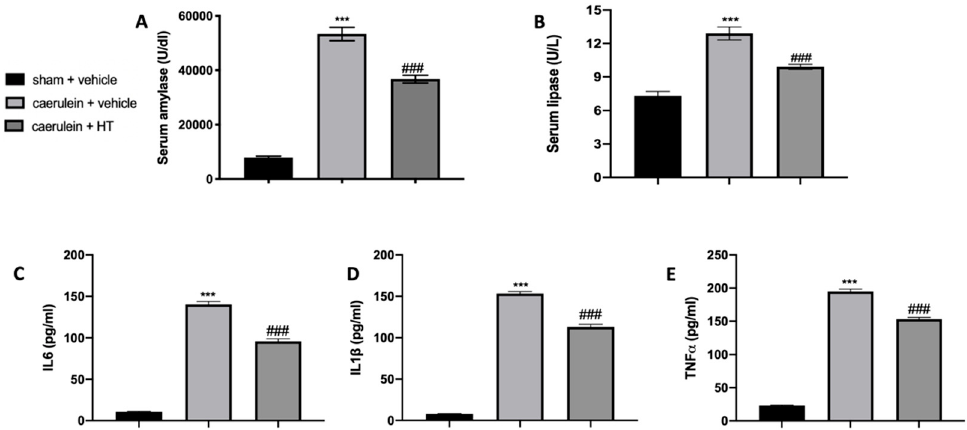
Figure 1. Hydroxytyrosol (HT) effect on serum parameter changes induced by caerulein administration: amylase ( A ), lipase ( B ), interleukin 6 (IL-6) ( C ), interleukin 1beta (IL-1 β ) ( D ) and tumor necrosis factor alpha (TNF- α ) ( E ). For each analysis, n = 5 animals from each group were employed. A p - value < 0.05 was considered significant. *** p < 0.001 vs. sham + vehicle, ### p < 0.001 vs. caerulein + vehicle.